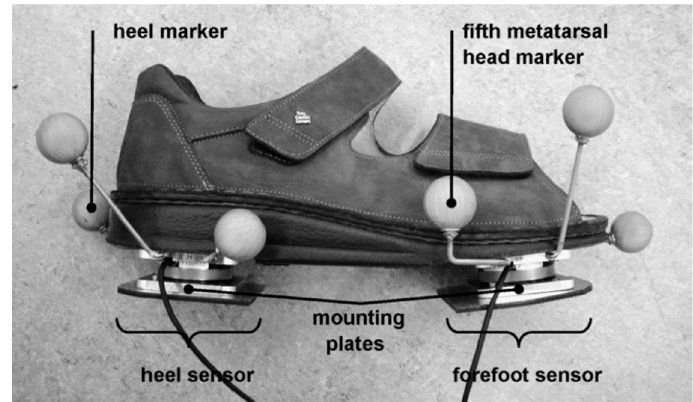
Figure 17. The instrumented shoe used by Liedtke, et al. [90].